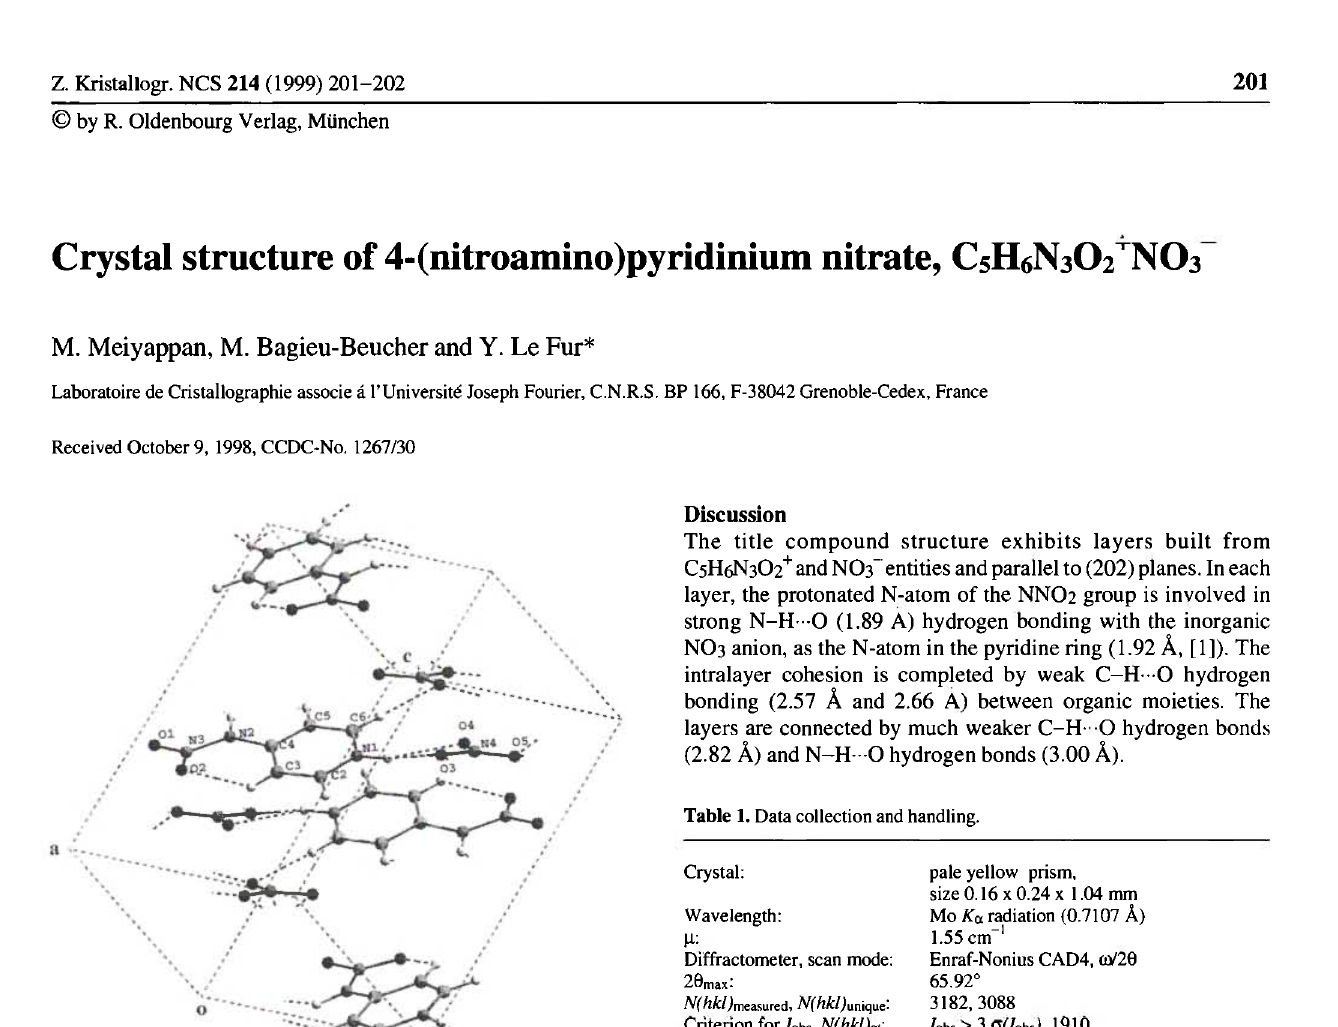
Table 2. Atomic coordinates and displacement parameters (in Ä 2 ).